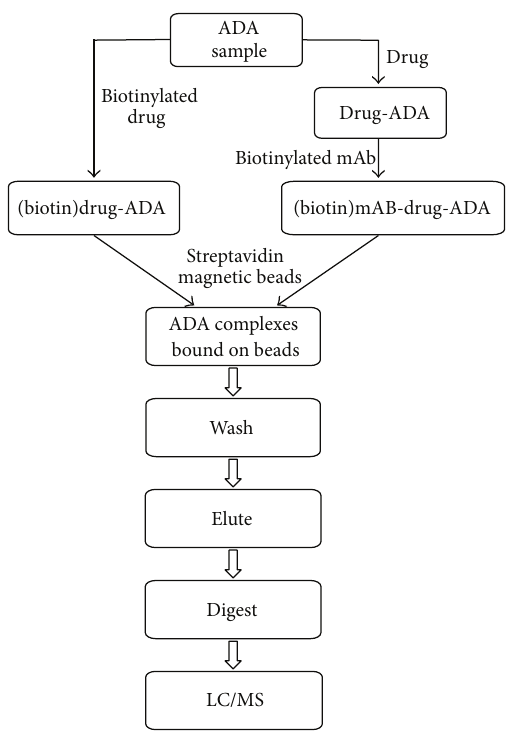
Figure 1: Immunocapture-LC/MS workflow chart.